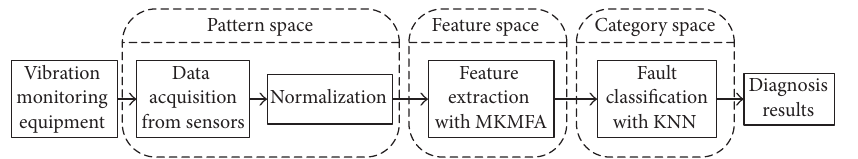
Figure 2: The flow chart of the proposed fault diagnosis procedure.